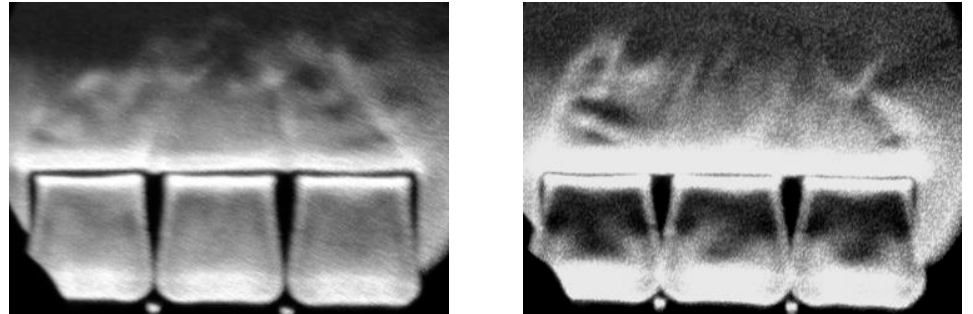
Figure 14. Schlieren images recorded during heating of the 60 × 60 mm sections.